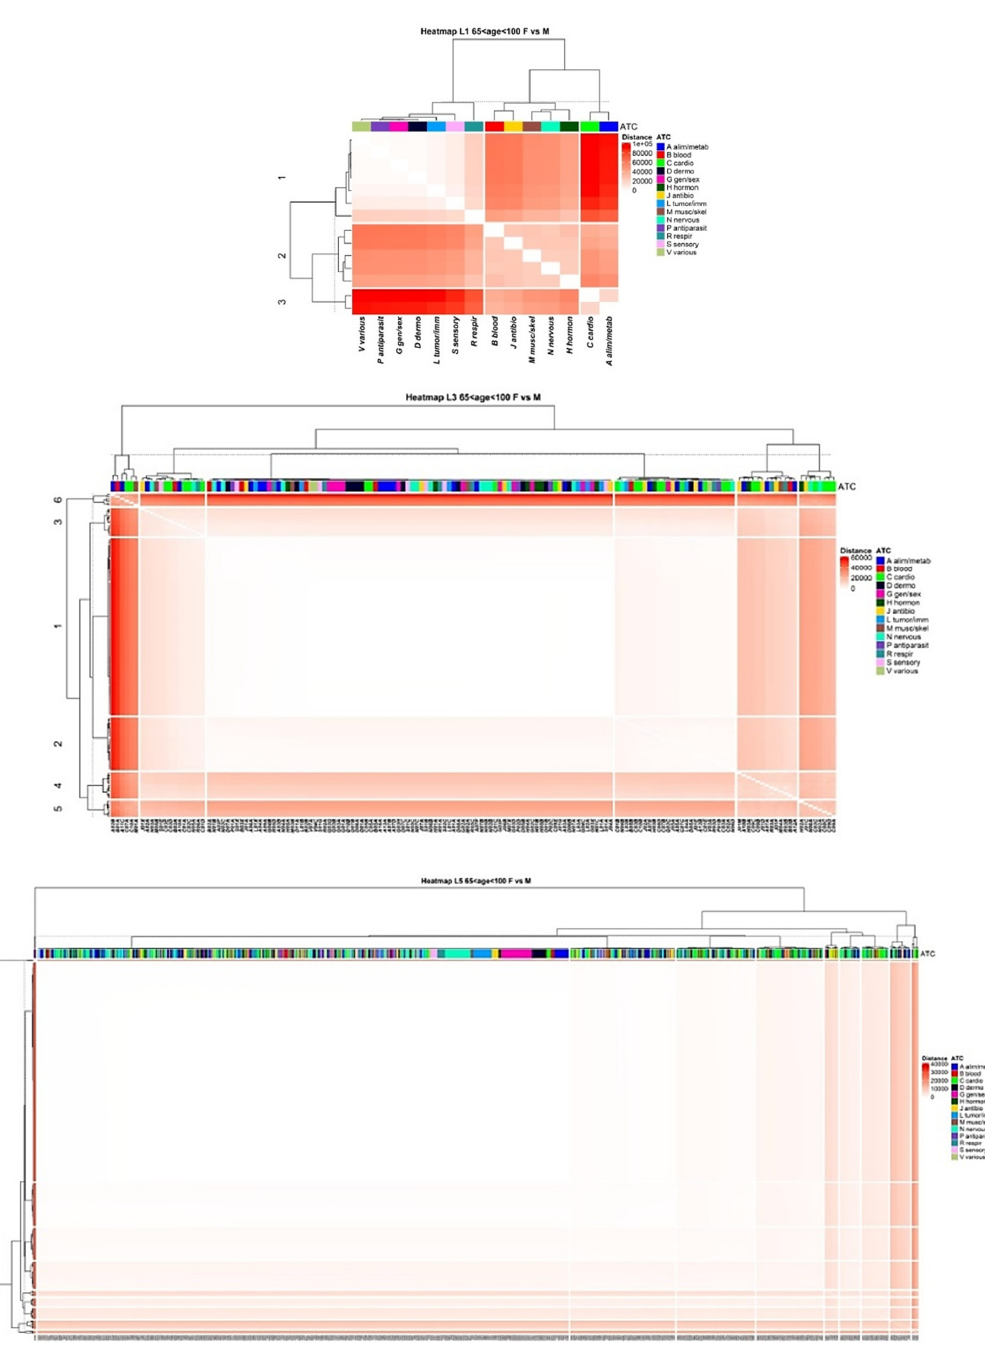
Figure 7. Distance matrices for three ATC levels to compare females vs. males at the 65–100 years-of-age strata. The colour in entry ( i , j ) is the Euclidean distance between layers i (females) and j (males) of the binary drug prescription networks. Euclidean distances are coded by colours from white (small distance) to red (large distance). Nodes were coloured according to the 14 groups found at the first level of the ATC classification system. Dendrograms identify a number of clusters in the distance